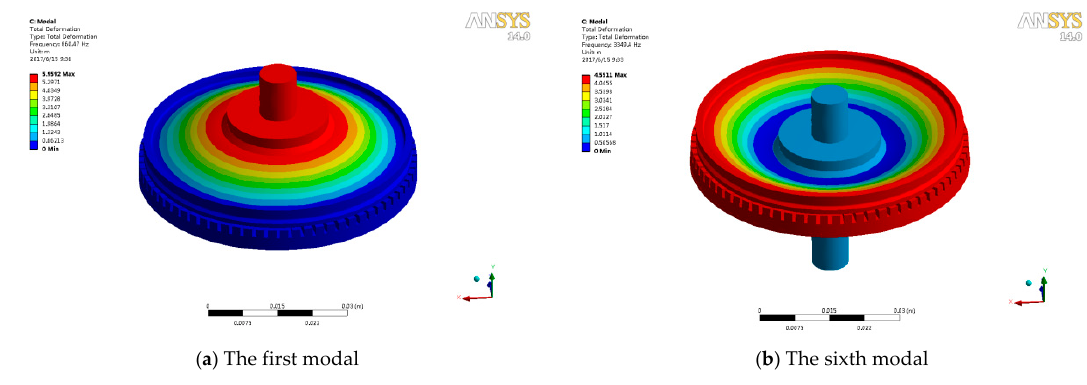
Figure 4. First and sixth natural frequency of an ultrasonic motor.